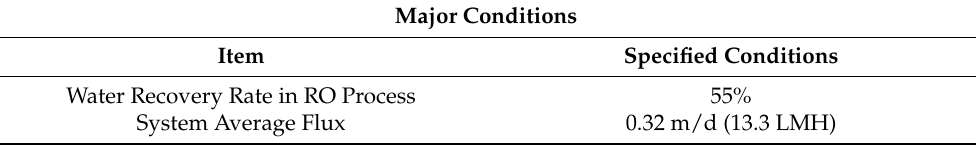
Table 2. Operating